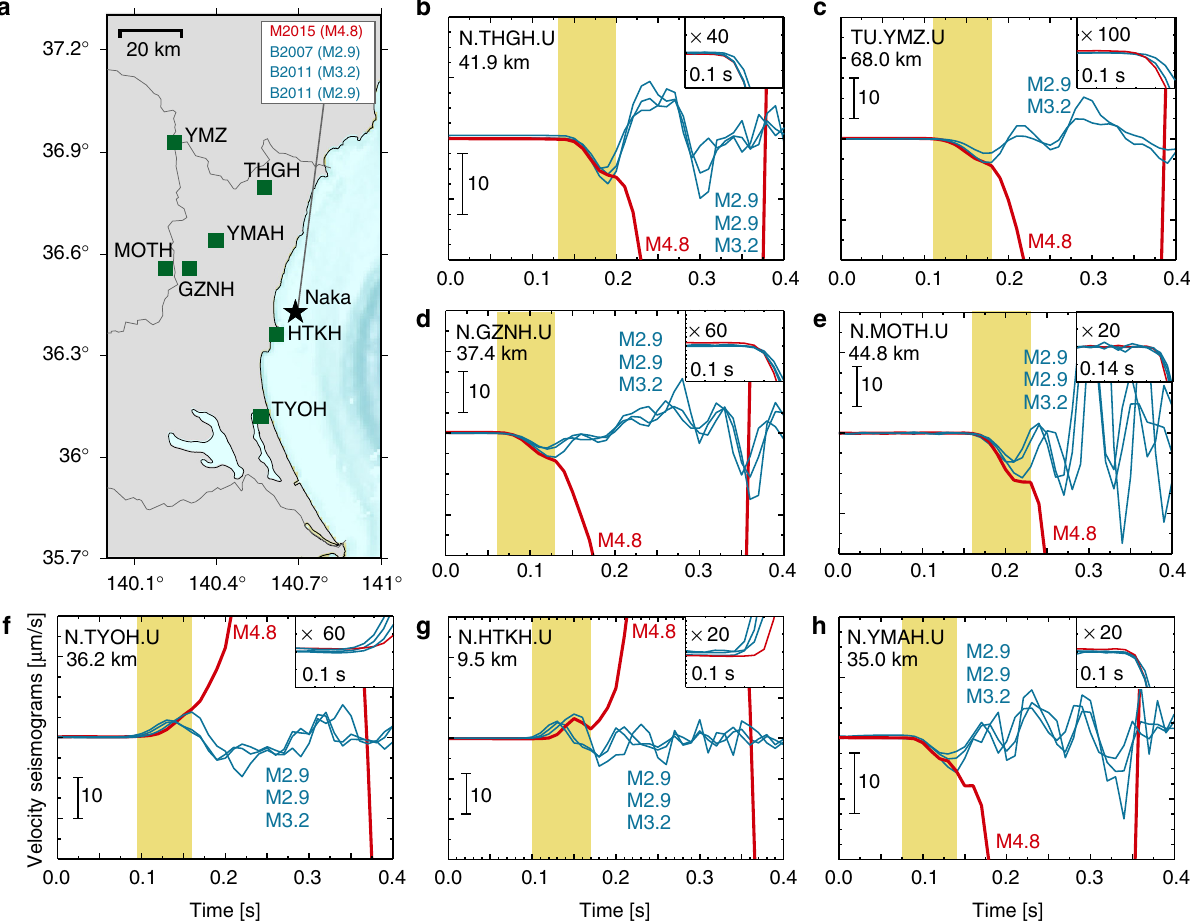
Fig. 2 Seismogram comparison between the M2015 ( M 4.8) earthquake and three smaller group B earthquakes ( M 3.2, M 2.9, and M 2.9). a Map showing the locations of stations (squares) used in the waveform comparison, relative to the Naka events (star). Waveform comparison at each station: b N.THGH. c TU.TMZ. d N.GZNH. e N.MOTH. f N.TYOH. g N.HTKH. h N.YMAH. The vertical components of the raw seismograms are shown, with the onset of the P- waves magni fi ed in the inset. The yellow zone indicates the 0.07 s time interval, which is the typical rupture duration of an M 3 event, starting from the onset of P-waves. The relative arrival time differences at each station are preserved. The number under each station name shows the epicentre